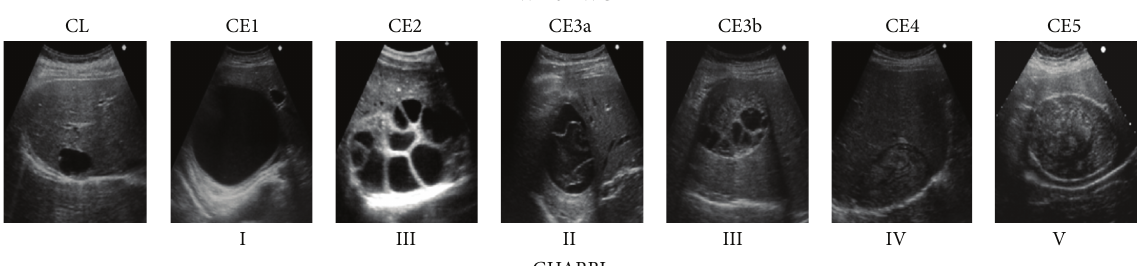
Figure 5: WHO-IWGE international standardized CE classification modified by Brunetti et al. International CE Workshop in Lima, Peru, 2009 [12]. Cystic echinococcosis: chronic, complex, and still neglected. PLoS Negl Trop Dis. 2011; 5(7):e1146. Note the external calcification of CE5.